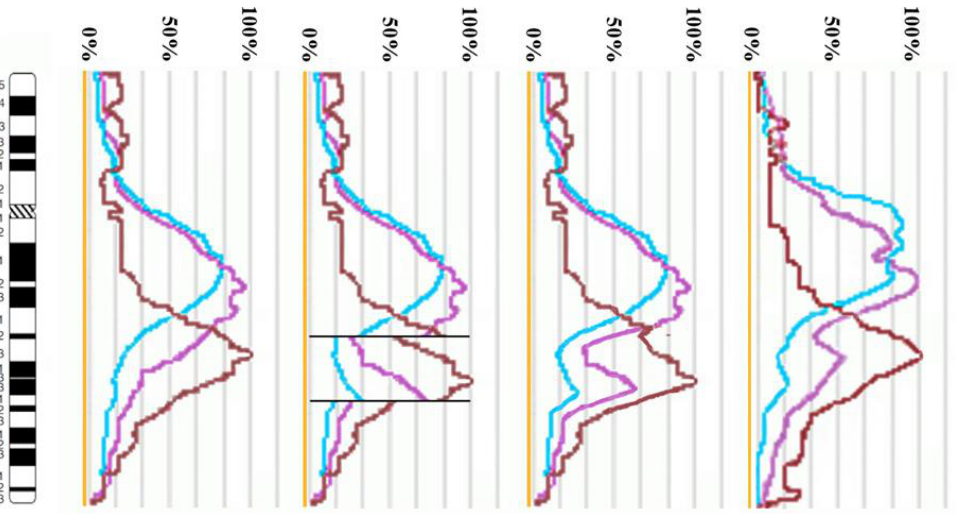
Figure 7. The scheme of hypothetical breakpoints of the inversion in 10q22.3 → q23.3 bands, as proposed on the basis of GTG-banding analysis.